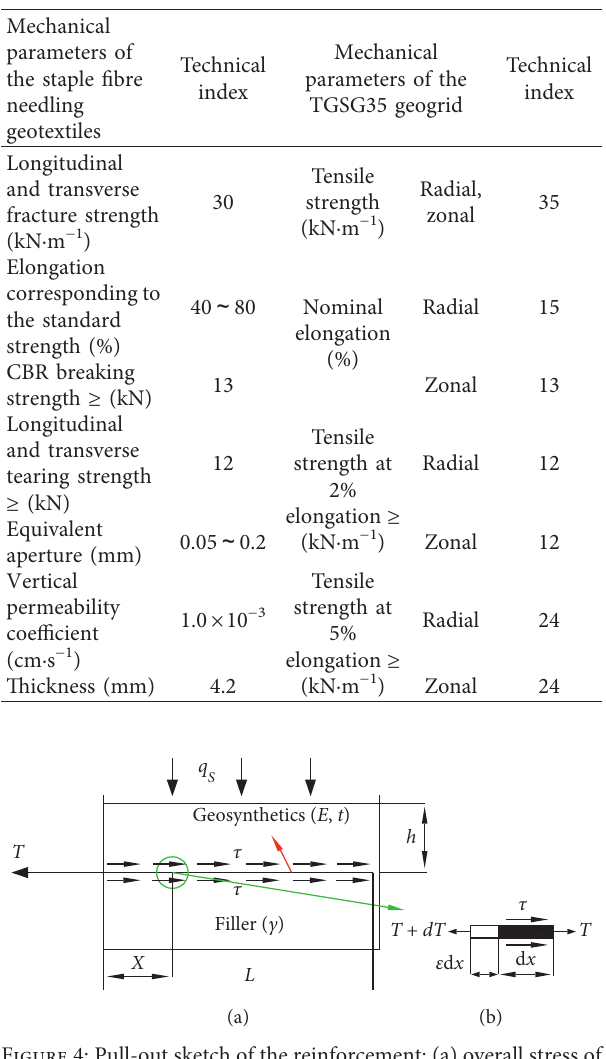
Table 1: The technology parameters of the geogrids.